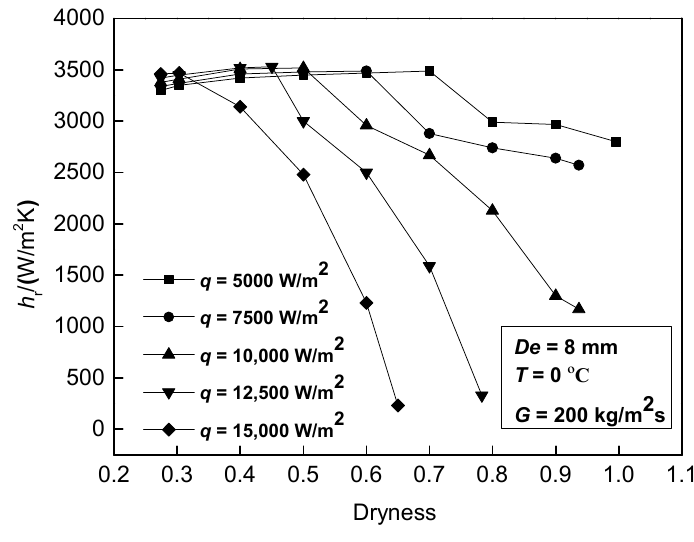
Figure 6. Effect of heat flux on h r. Figure 6. E ff ect of heat flux on h